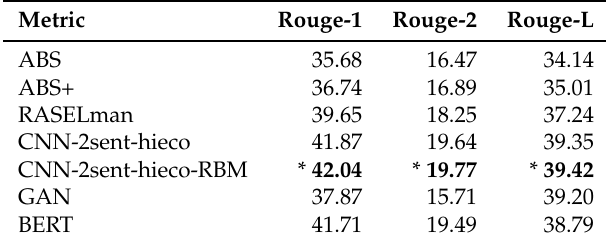
Table 3. The experimental results on CNN/Daily Mail testing datasets. * indicates the statistical significant improvement.